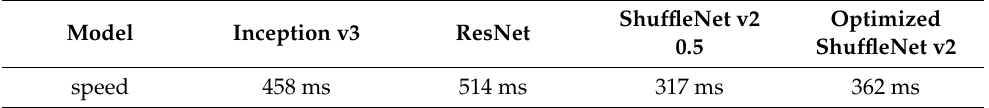
Table 6. Recognition speed of different